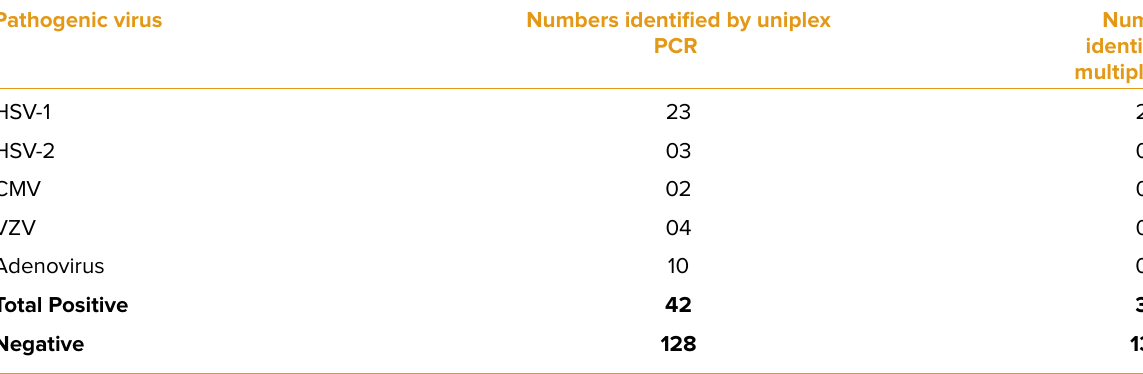
Table 2. Results of uniplex and multiplex PCRs in test samples Pathogenic